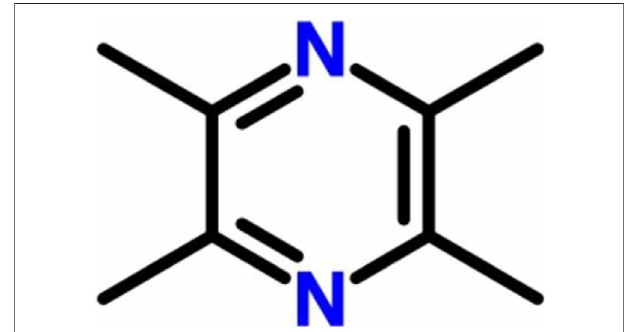
FIGURE 1 | Chemical structure of